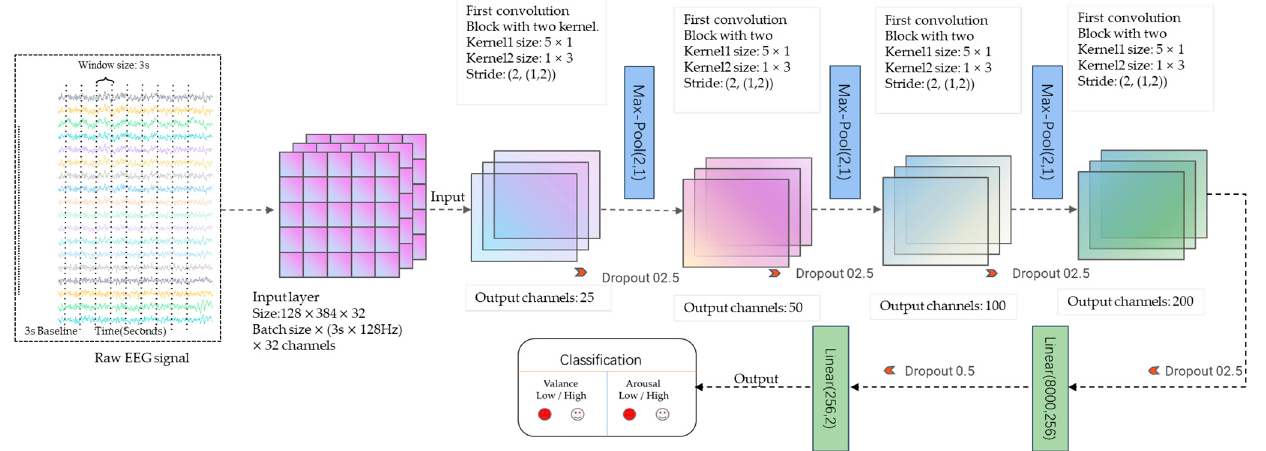
Figure 8. The architecture of the proposed network. Table 2. The shapes of the proposed model.